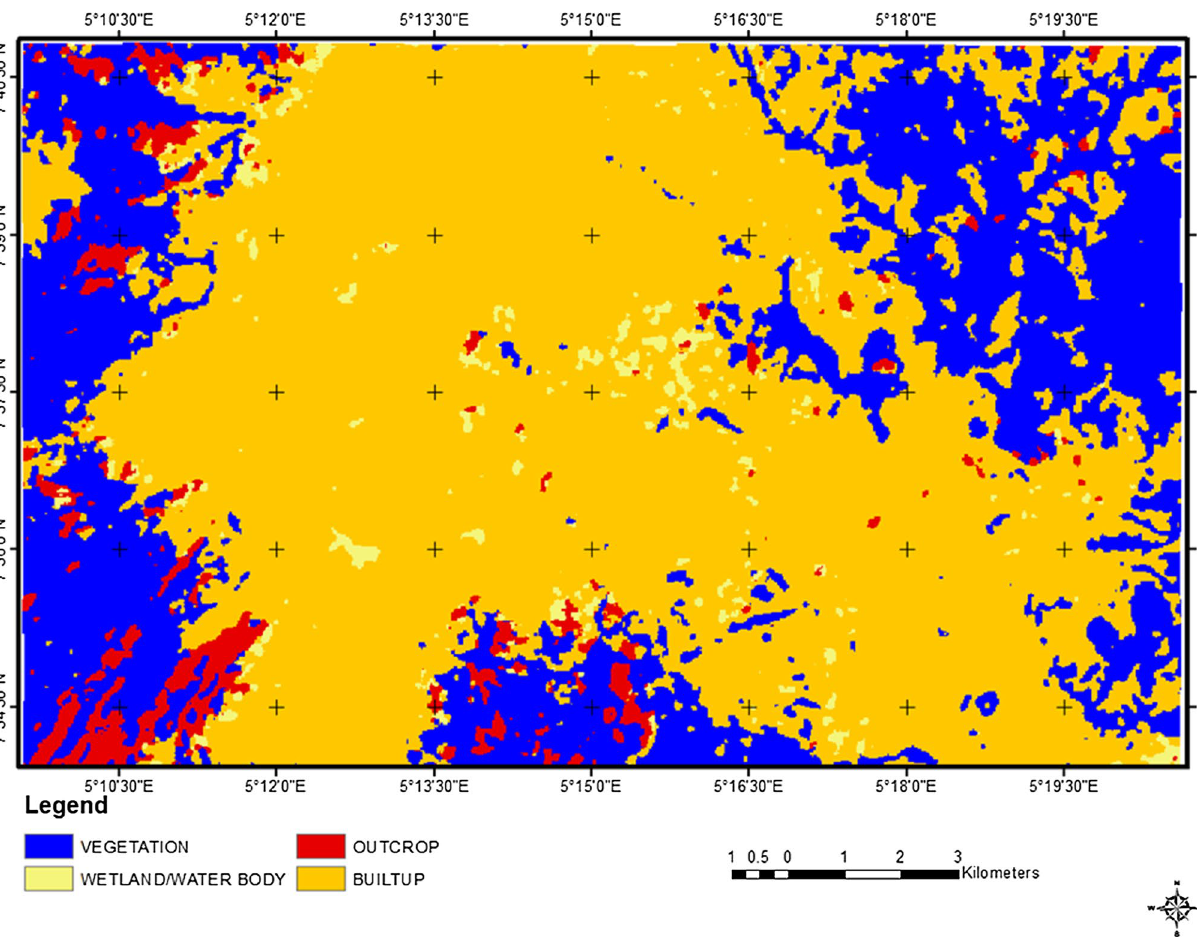
Fig. 9 Landuse/landcover map of the study